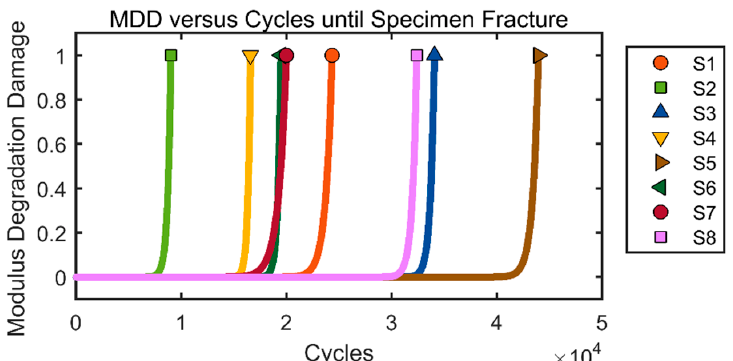
Figure 7. Cumulative trend for three parameters versus fatigue cycles for specimen 1 (S1) to specimen 8 (S8): ( a ) cumulative instantaneous entropy; ( b ) cumulative counts; and ( c ) cumulative energy.